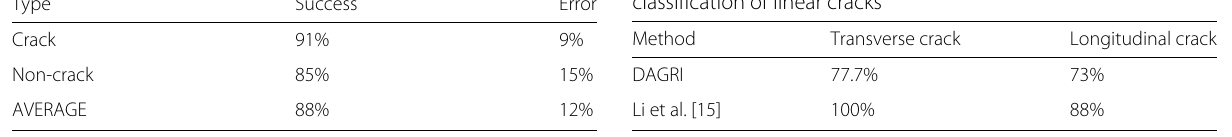
Table 6 Comparative results with Li et al. method